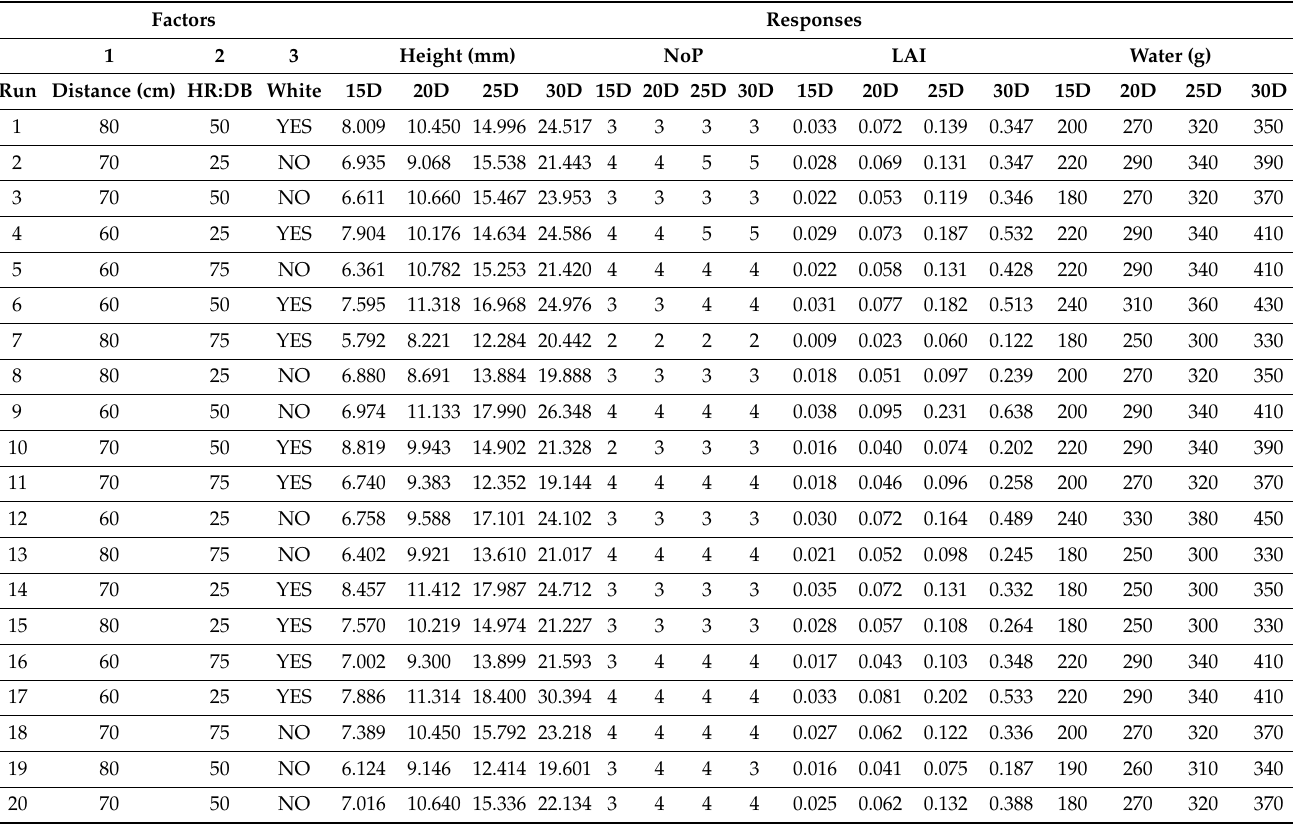
Table 6. Results summary.